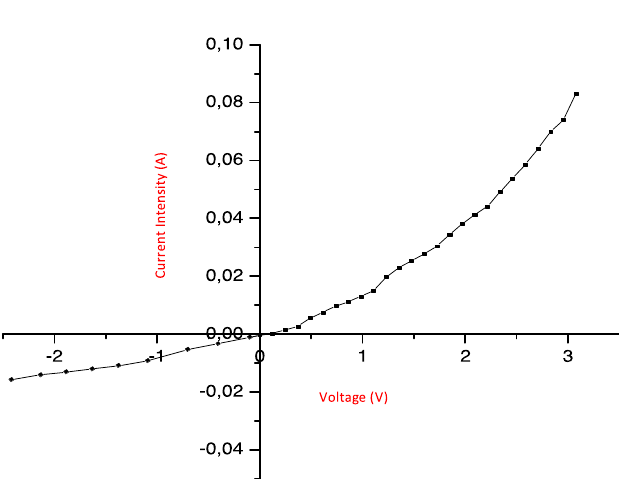
Fig. 5. I – V characteristic of the ZnO/Ge photodiode.